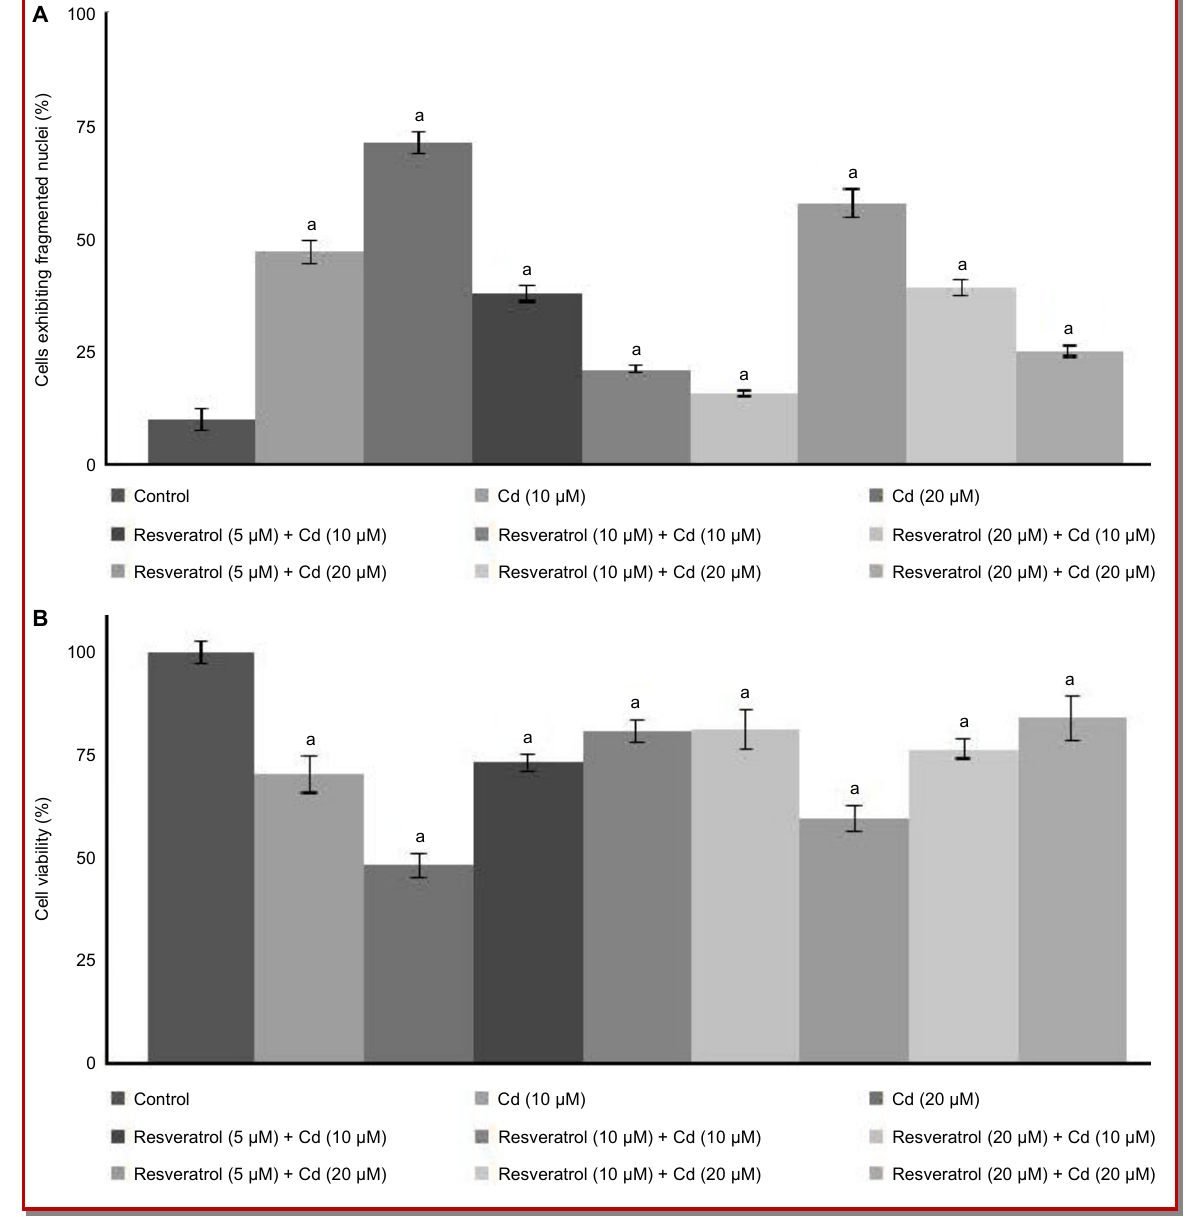
Figure 1: Resveratrol inhibits cadmium induced neuroapoptosis Pre-treatment with resveratrol markedly reduction in morphological changes as seen by DAPI staining (A) and improved the viable cell percentage (B); Values are represented as mean ± SD; n=6; a represents statistical significance at p<0.05 compared against control as determined by one-way